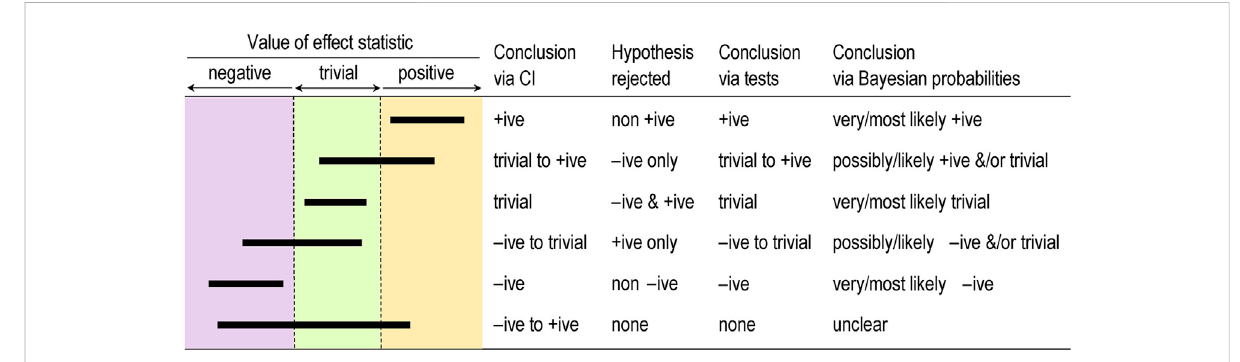
FIGURE 1 Conclusions about effects determined by coverage of the con fi dence or compatibility interval (CI), by tests based on rejection of one-sided interval hypotheses, and by Bayesian probabilities, for six qualitatively different dispositions of 90% CI (bars) relative to substantial and trivial magnitudes. +ive, substantial positive; − ive, substantial